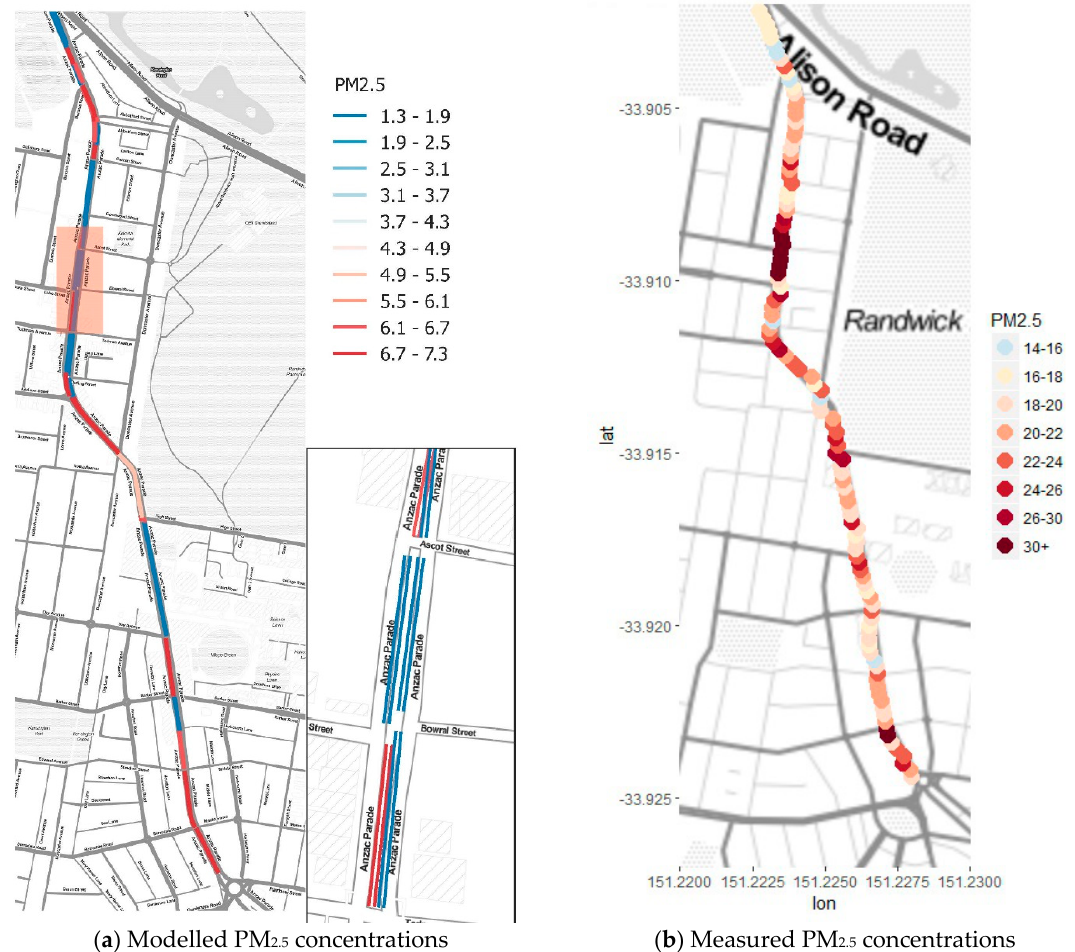
Figure 9. ( a ) Modelled PM 2.5 emissions in g hr − 1 (red shaded area indicates where heavy Figure9. ( a )ModelledPM 2.5 emissionsinghr − 1 (redshadedareaindicateswhereheavyconstructionwas construction was present), ( b ) uncorrected DustTrak measured PM 2.5 concentrations in µg/m 3 shown present),( b )uncorrectedDustTrakmeasuredPM 2.5 concentrationsin µ g / m 3 on the right-hand side.